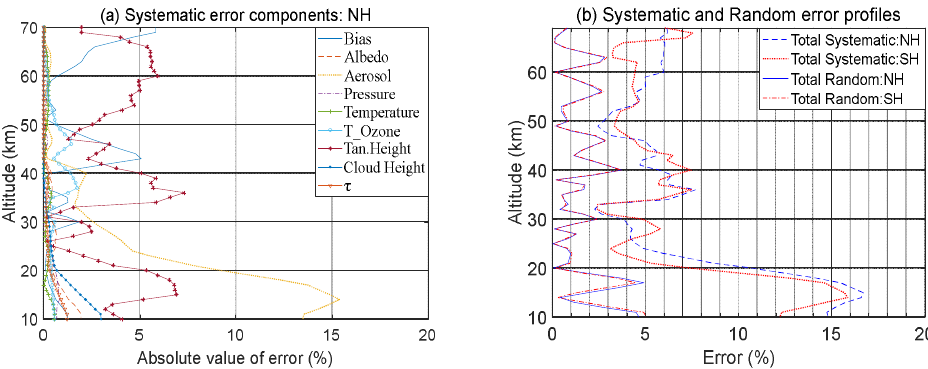
Figure 13. ( a ) Average error profiles for each systematic error component in the NH, using the same parameters as in Figure 12; ( b ) total systematic and random errors in both hemispheres.